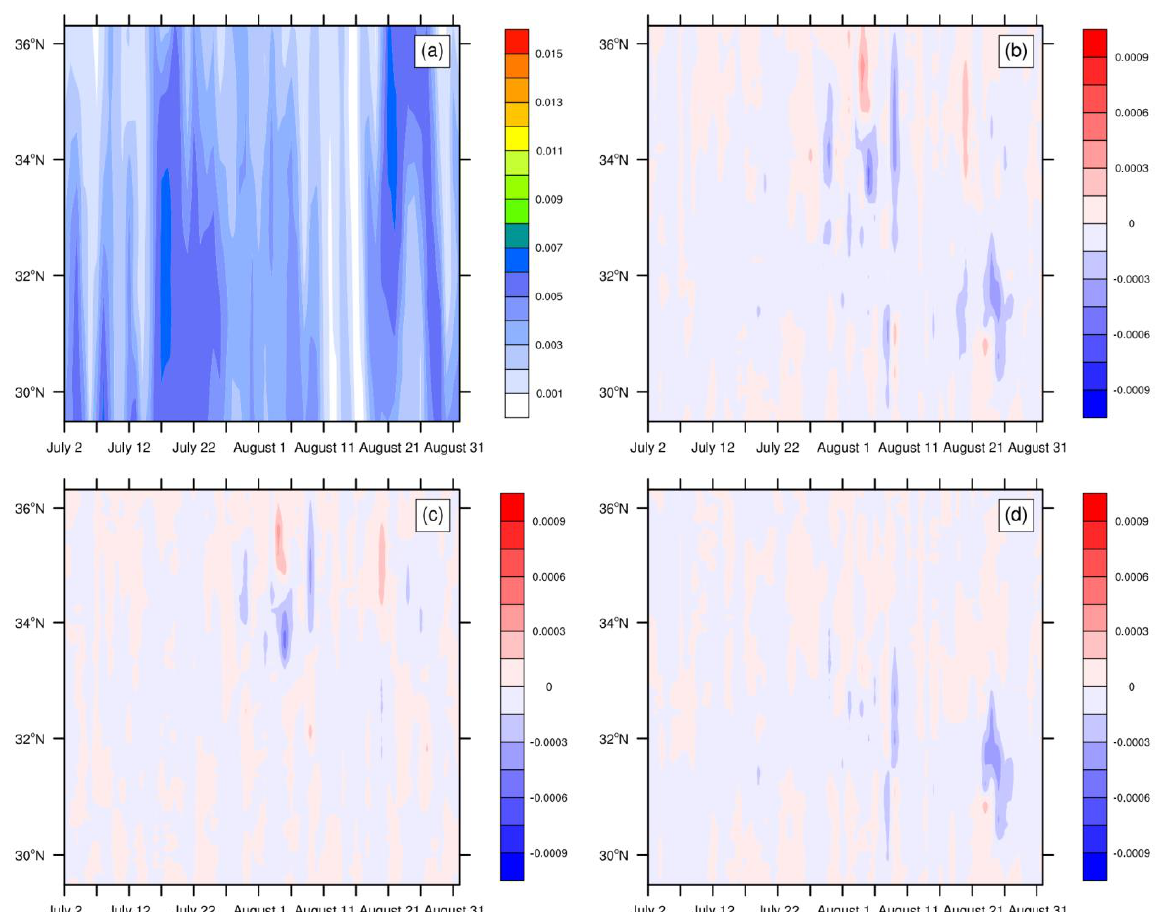
Figure 8. Time – latitude diagrams of water vapor mixing ratio (kg kg −1 ) at 500 hPa averaged in domain 3 in CTRL ( a ). Panels ( b – d ) are the differences ( b ) between LowQD and CTRL (LowQD minus CTRL), ( c ) between LowQ and CTRL (LowQ minus CTRL), as well as ( d ) between LowD and CTRL (LowD minus CTRL), respectively. Blue (red) shading indicates negative (positive) variation.